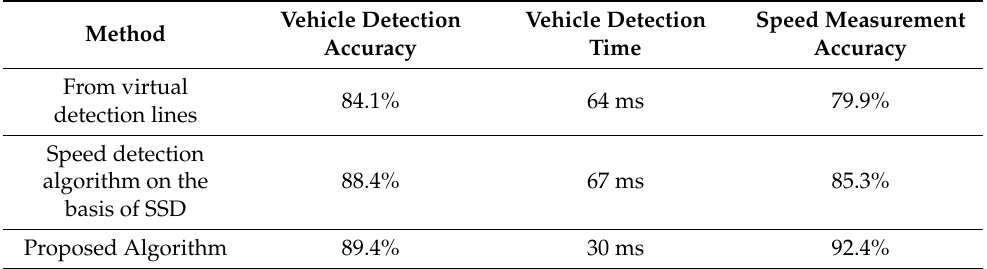
Table 6. Rain test results.